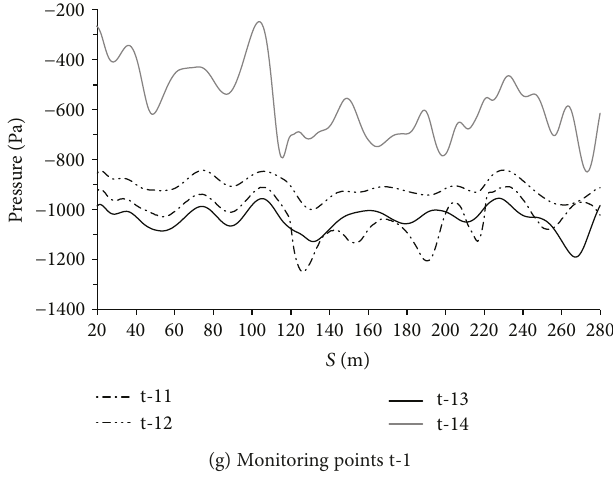
Figure 12: Pressure change curves at di ff erent monitoring